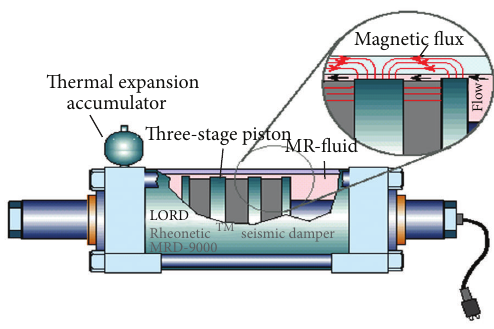
Figure 1: Schematic of a full-scale 20-ton MR fluid damper